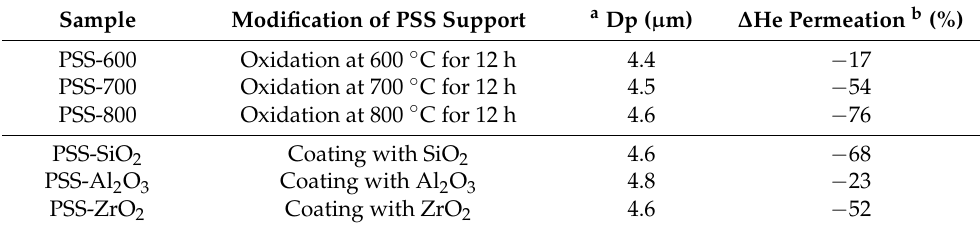
Table 1. Modified-PSS support